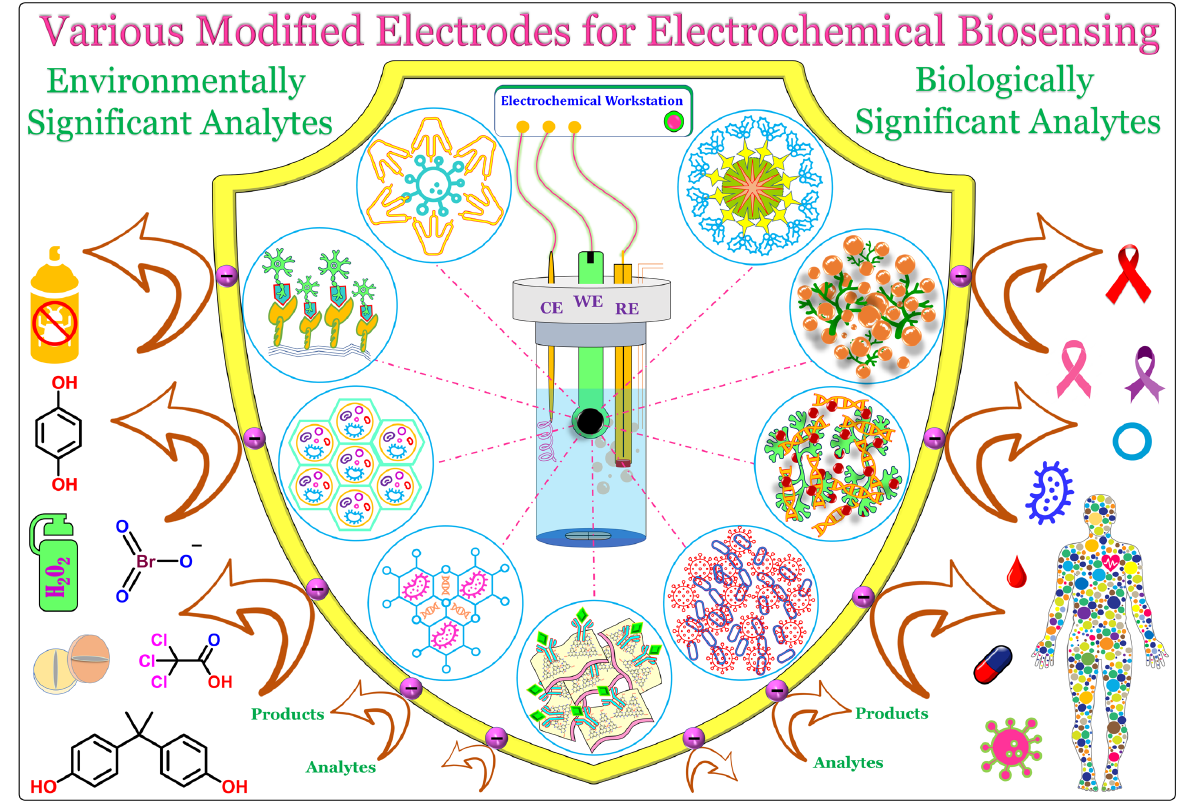
Figure 1. A conventional three-electrode setup (CE—counter electrode; WE—working electrode; RE—reference electrode) and biosensors fabricated using various functional materials and molecules (functionalized carbons and dendrimers, quantum dots and metal nanoparticles-decorated 2D materials, metal and covalent organic frameworks, porous materials and functionalized ionic liquids) for the electrochemical biosensing of biologically and environmentally significant analytes.